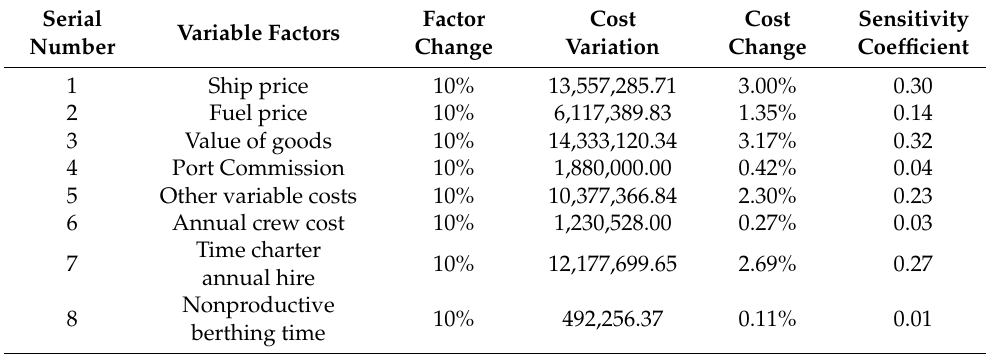
Table 8. Sensitivity